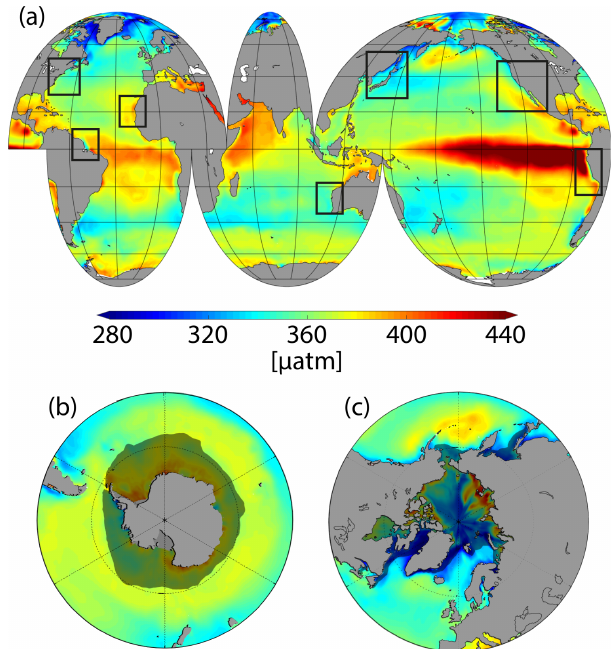
Figure 5. (a) Climatological mean p CO 2 of the merged product presented in this study. Panels (b) and (c) highlight the polar re- gions. Black boxes in (a) illustrate regions that are further investi- gated in the regional analysis. Shaded areas in (b) and (c) delineate the maximum sea ice extend.